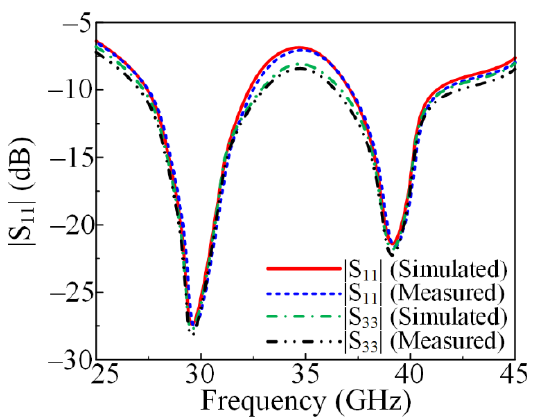
Figure 10. Comparison of measured and simulated reflection coefficients with parasitic element.